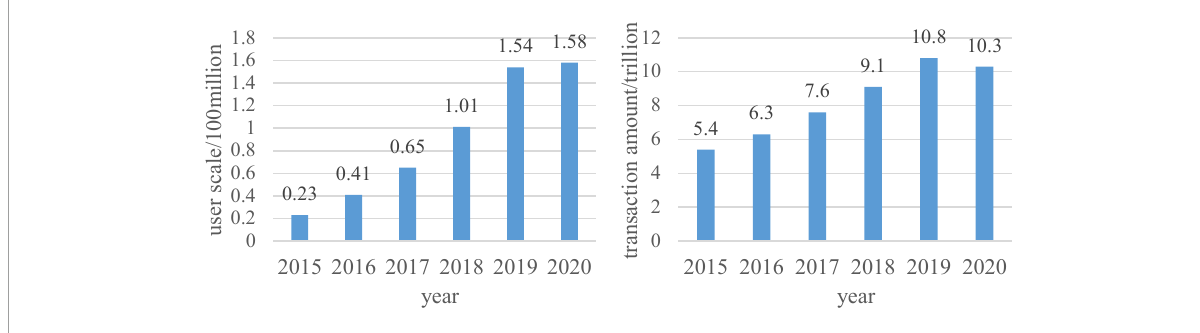
FIGURE7 The scale of China’s overseas online shopping users and the scale of cross-border e-commerce transactions.